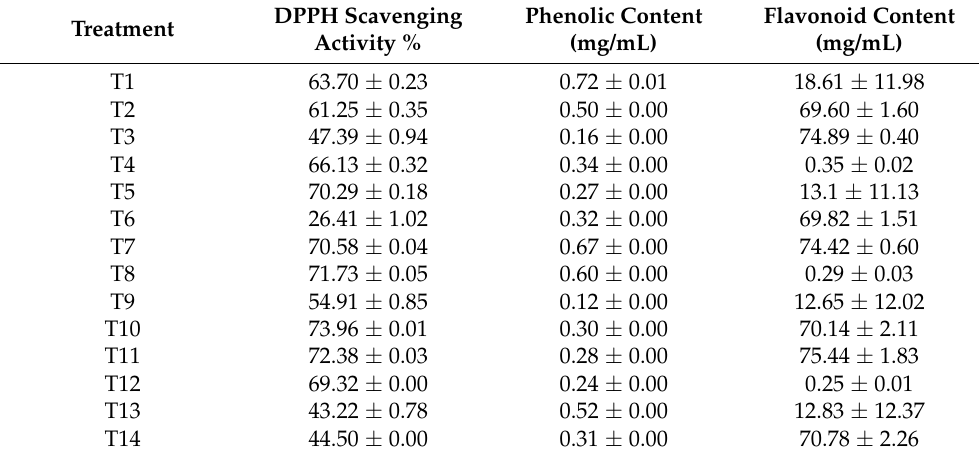
Table 2. Phytochemical analyses of moringa leaf juice extracted via various methods. DPPH Scavenging Phenolic Content Flavonoid Content Treatment Activity % (mg/mL)